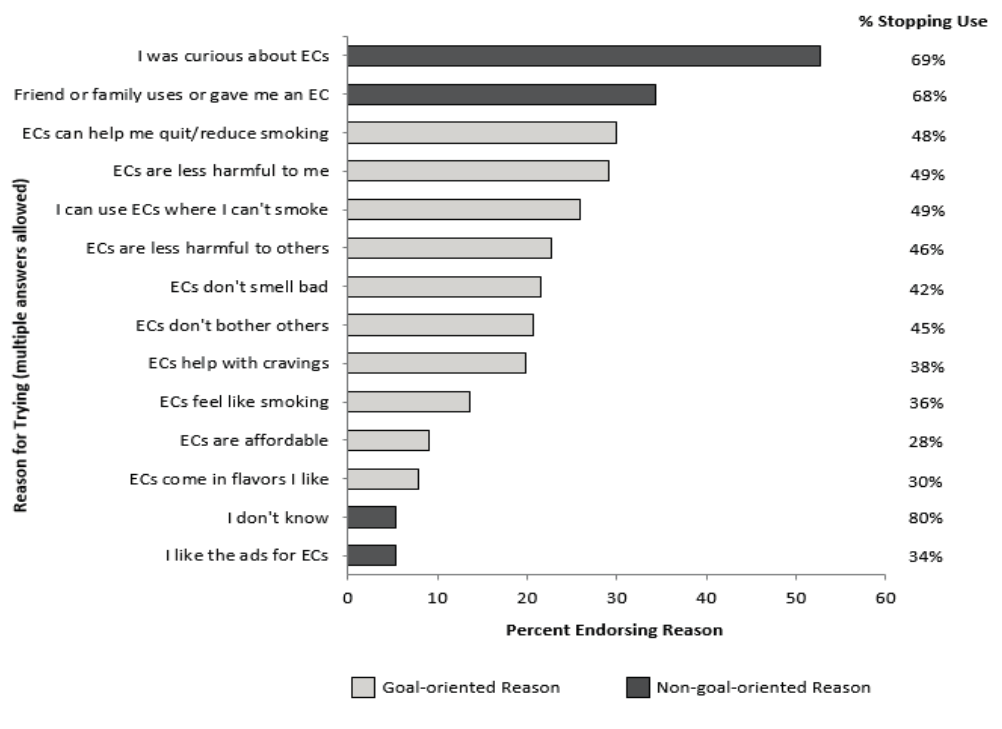
Figure 1. Reasons for trying e-cigarettes (ECs) (multiple answers allowed) and percent stopping EC use among those who endorsed that reason ( n =